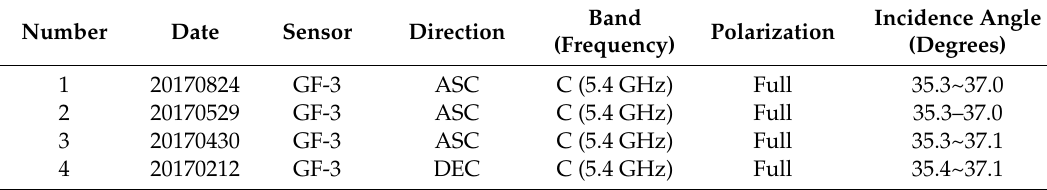
Table 2. Description of the first group of time-series